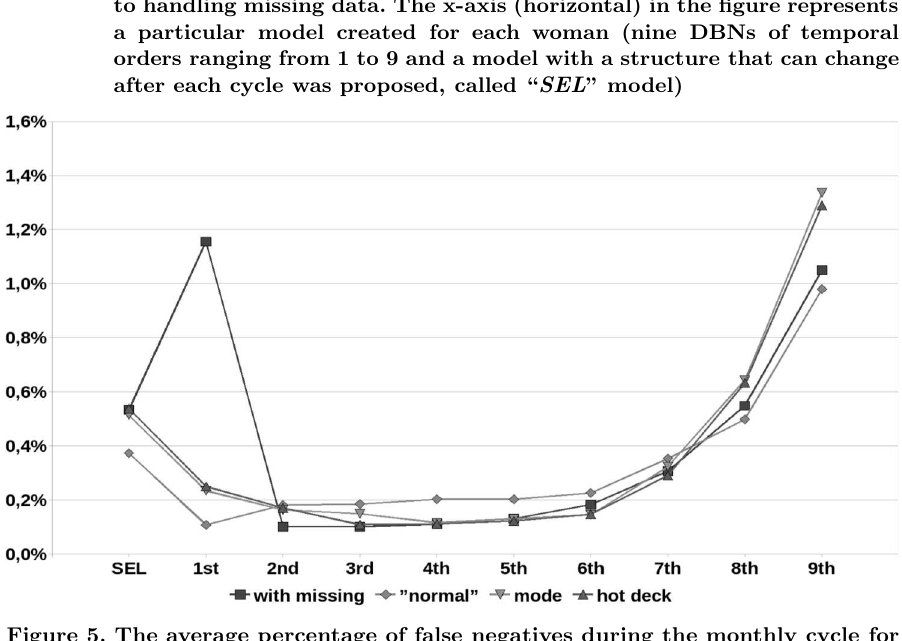
Figure 5. The average percentage of false negatives during the monthly cycle for each of the compared DBN models for selected approaches to handling missing data. The x-axis (horizontal) in the figure represents a particular model created for each woman (nine DBNs of temporal orders ranging from 1 to 9 and a model with a structure that can change after each cycle was proposed, called “ SEL ”